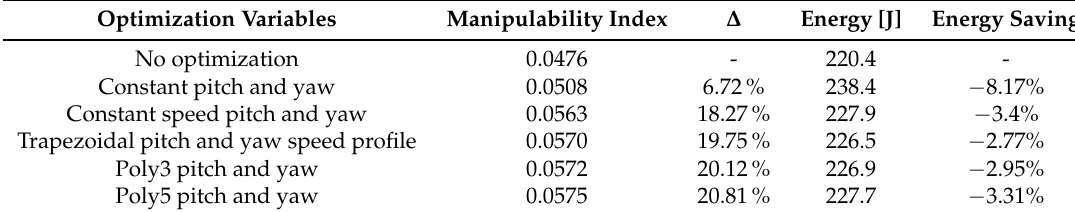
Table 6. Manipulability maximization: test-case I, motion along a horizontal line.